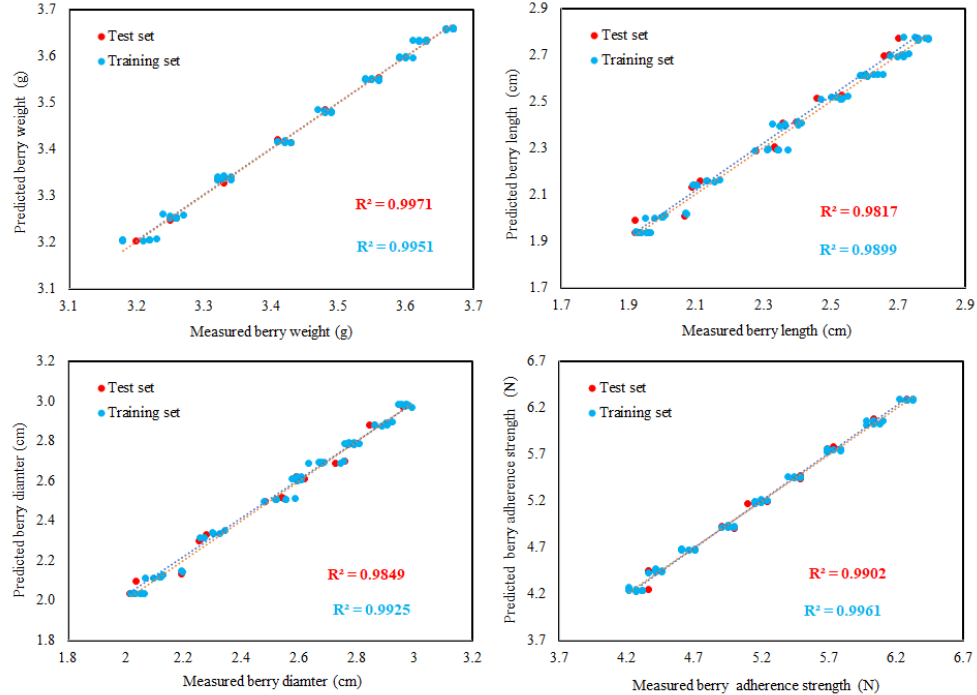
Figure 4. Predicted vs. experimental values of berry weight, berry length, and berry diameter berry adherence strength using the optimal ANN topology and training and testing sets. The coefficients of determination (R 2 ) are reported.